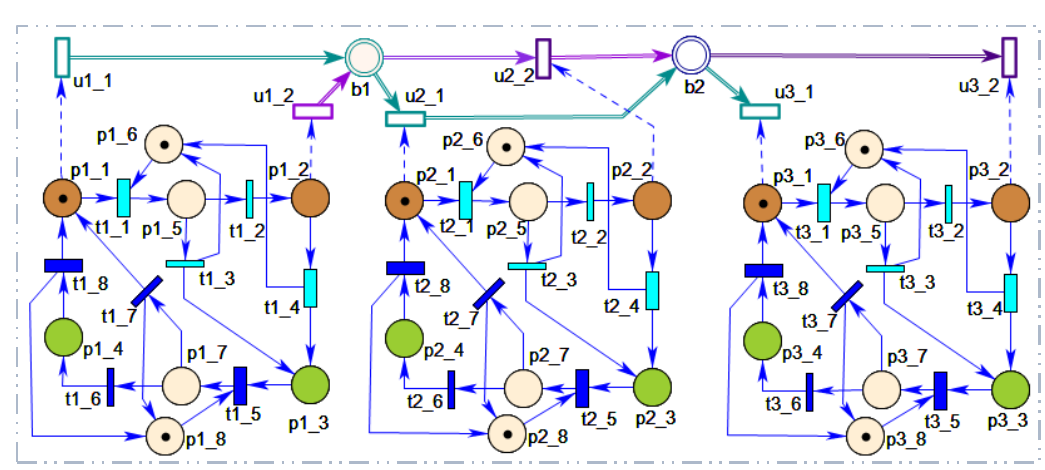
Figure 5 . Example оf 1 FSHPN mоdel оf a VCN with 3 servers and 2